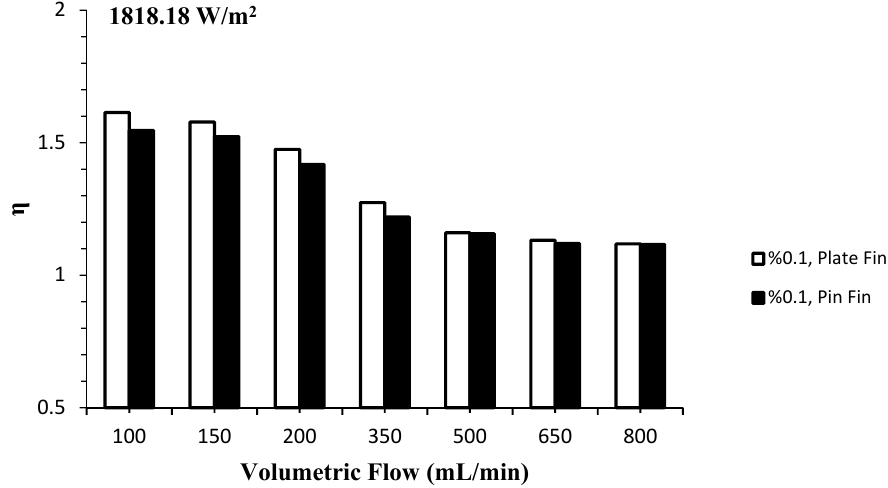
Figure 12. Performance index variations of the plate fin and pin fin heat sinks.